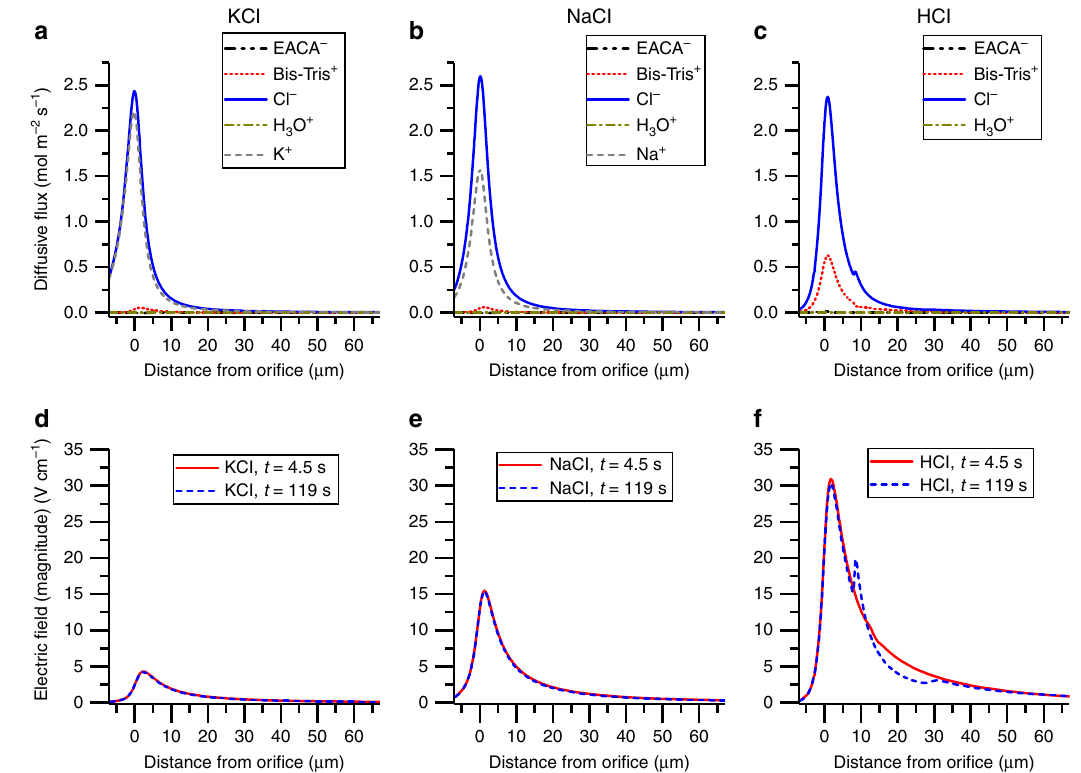
Fig. 6 Centerline ion diffusive fl uxes and magnitude of the induced electric fi eld in KCl, HCl, and NaCl simulations. The simulation conditions are the same as Fig. 5: both reservoir and running buffers contain 1X EB; running buffer contains an additional 9 mM of KCl (left), NaCl (middle), or HCl (right). Diffusive fl uxes of ions at 119 s time point in a KCl, b NaCl, and c HCl are plotted along the centerline of the capillary as a function of distance into the reservoir. The capillary ori fi ce is located at x = 0. Cl − is the majority anion carrier in all cases (blue, solid). In KCl a , the diffusive fl ux of K + (grey, dashed) is almost as high as Cl − , and the rest of the ions are negligible. In b , Na + (gray, dashed) has the second largest fl ux, with the other ions negligible. In HCl c , Bis-Tris + (red, dotted) becomes the majority cation, though its fl ux is smaller than both Na + and K + . The magnitude of the induced electric fi eld generated by these ion fl uxes is plotted at 4.5 s (red, solid) and 119 s (blue, dashed) time points in d KCl, e NaCl, and f HCl. The largest fi eld is generated in HCl and extends tens of microns into the sample reservoir. NaCl generates the second largest fi eld, and KCl generates the smallest. The fi eld magnitude and shape are highly stable with time for all 3 conditions, except where the concentrated DNA bolus somewhat distorts the fi eld in HCl at 119